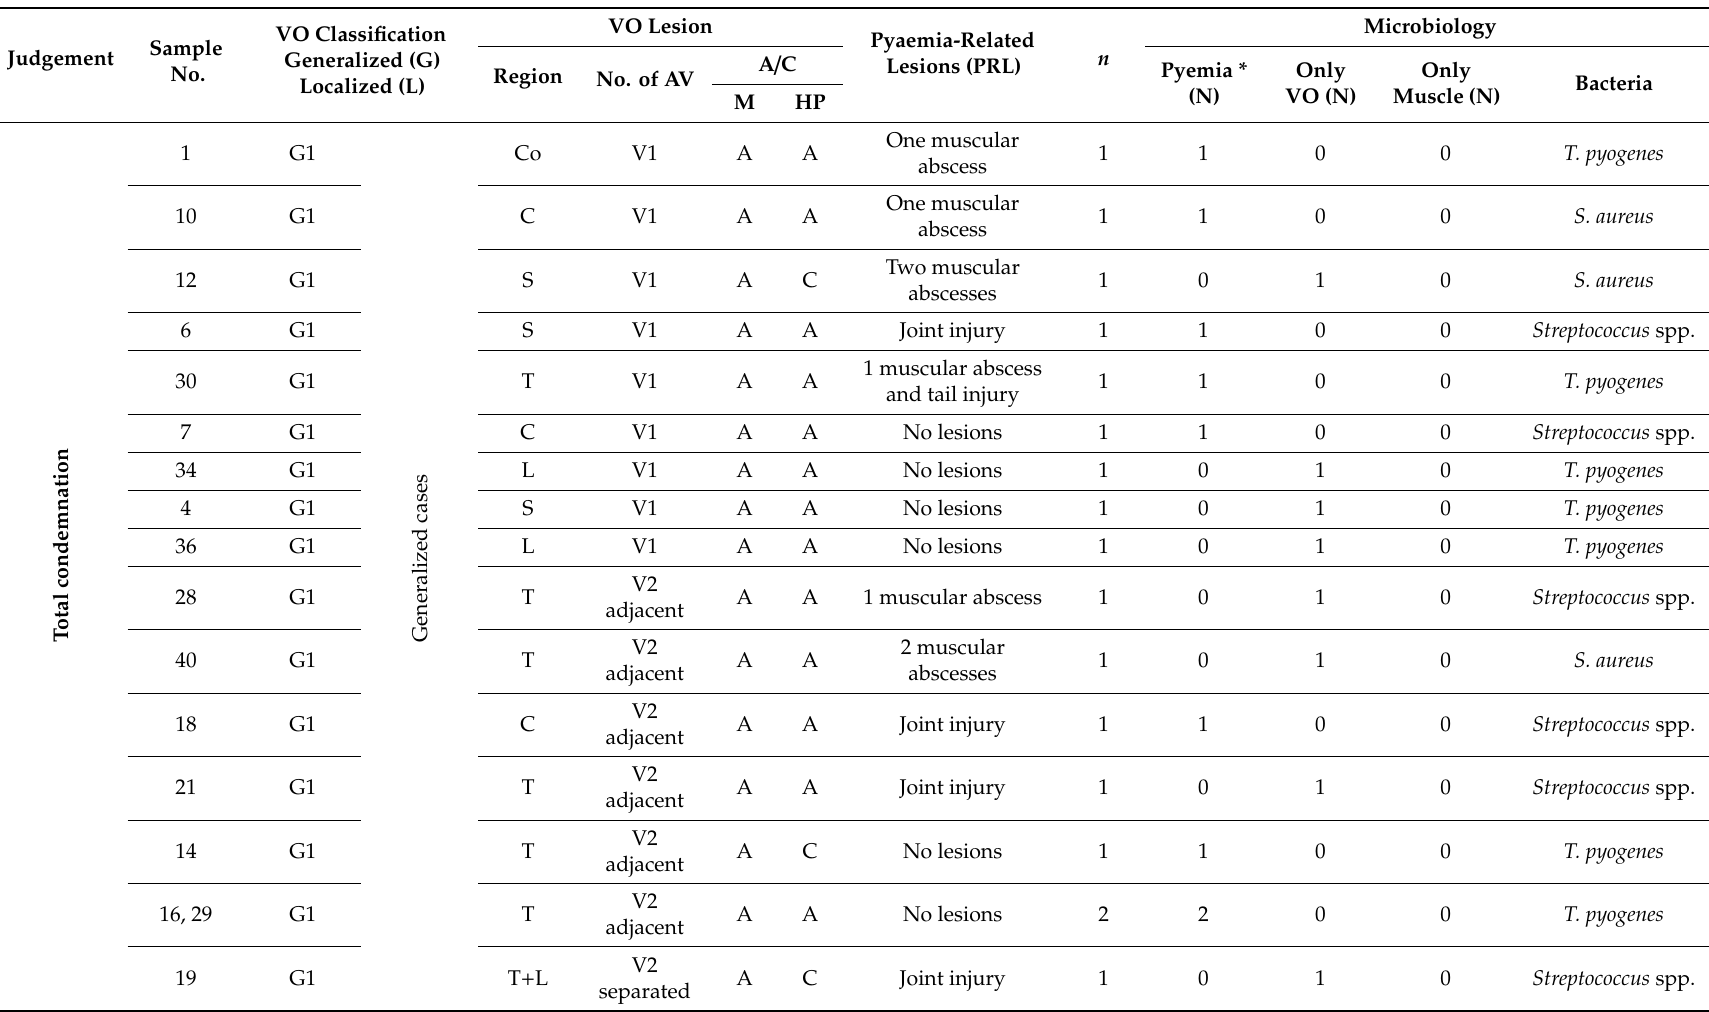
Table 5. Overall results achieved in this study: VO macroscopic characteristics, description of pyaemia-related lesions, judgment criteria, and microbiological results.